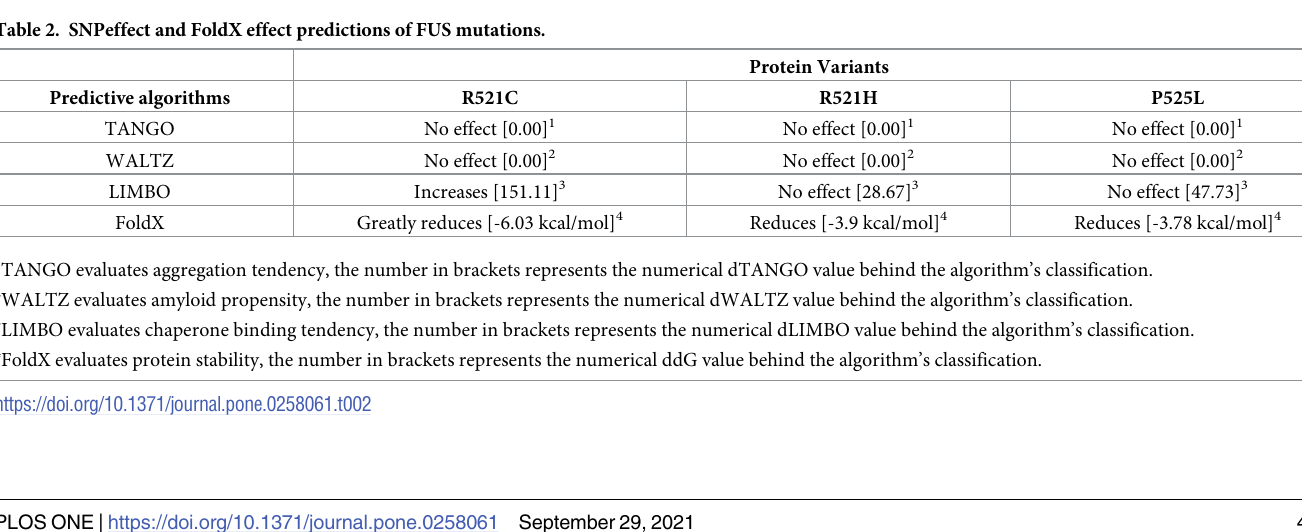
The numbers in brackets represent the disease probability according to SNPs&GO. 3 The numbers in brackets represent the reliability of the classification of PMut. 4